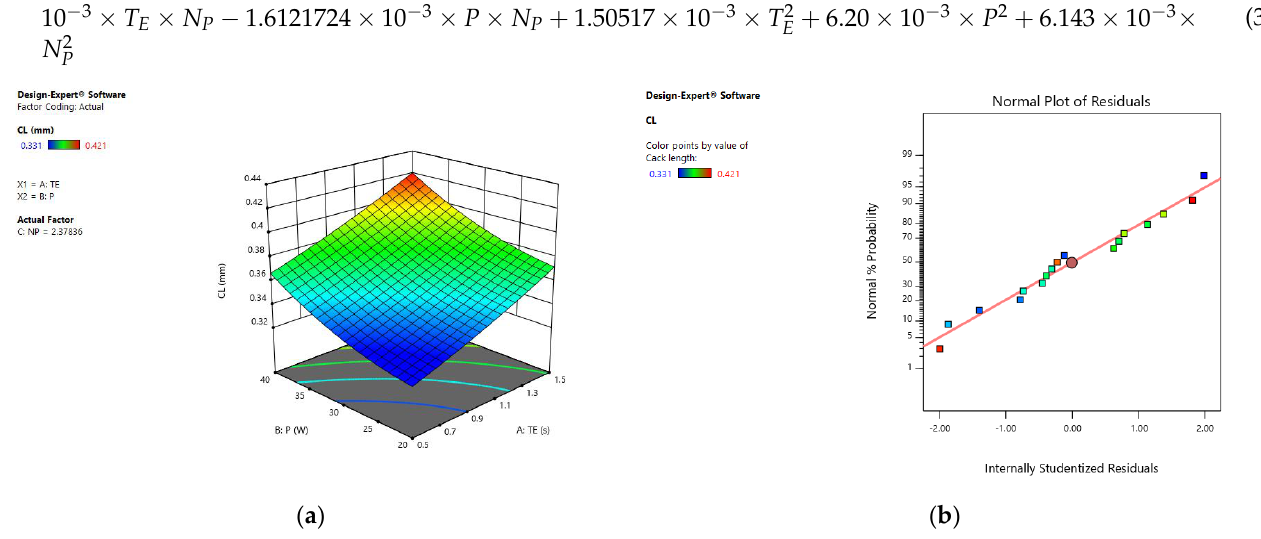
Figure 13. ANOVA model results for D INLET at 0.1 wt.% CNPs: ( a ) 3D response surface and ( b ) nor- mal residuals plot.